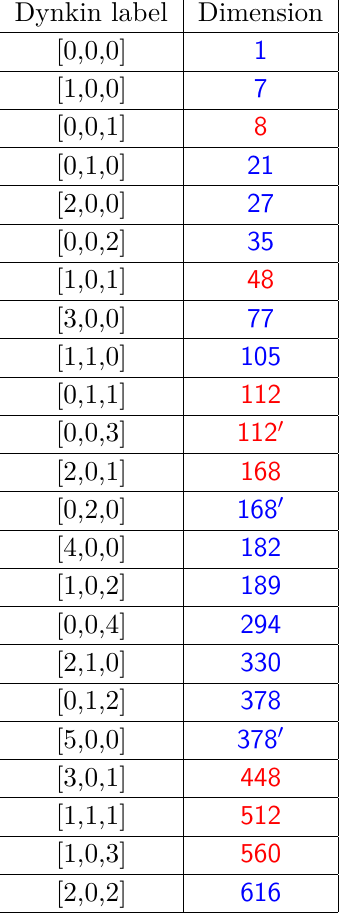
Table 6 . so (7) irreducible representations [9].